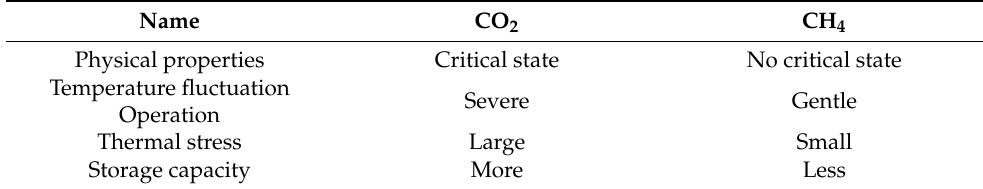
Figure 18. Tension stress distribution after 10-day CO 2 withdrawal. Table 4. Comparison of CO 2 and CH 4 in salt